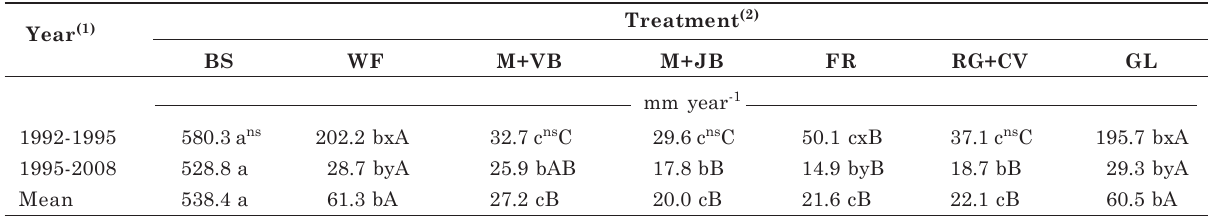
Table 5. Mean water runoff in different periods in a long-term experiment, comparing bare soil, grassland and no-tillage cropping systems